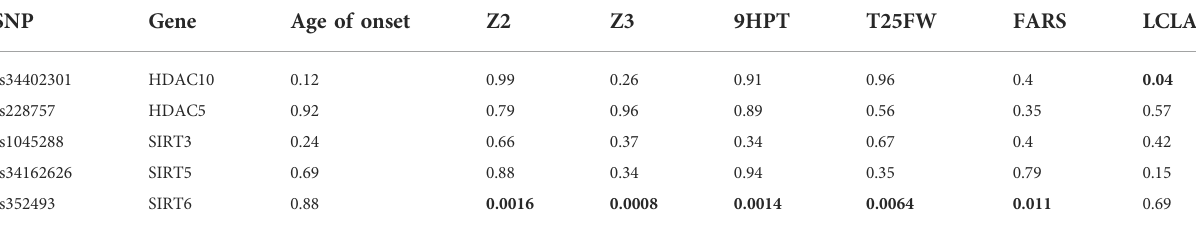
TABLE 1 Associations of HDAC gene polymorphisms with parameters of FRDA disease progression in 200 individuals with FRDA. Values are p values for correlations. p valuesthatare < 0.05areinbold. SNP= singlenucleotidepolymorphism,9HPT=9-holdpeg test,T25FW = timed25-footwalk, LCLA=low-contrast letteracuity,andFARS=FriedreichAtaxiaRatingScale.Z-score iscalculatedas(value-mean)/standarddeviation. Z2isthesum of the Z-scores for 9PHT and T25FW. Z3 is the sum of the Z-scores for 9HPT, T25FW, and